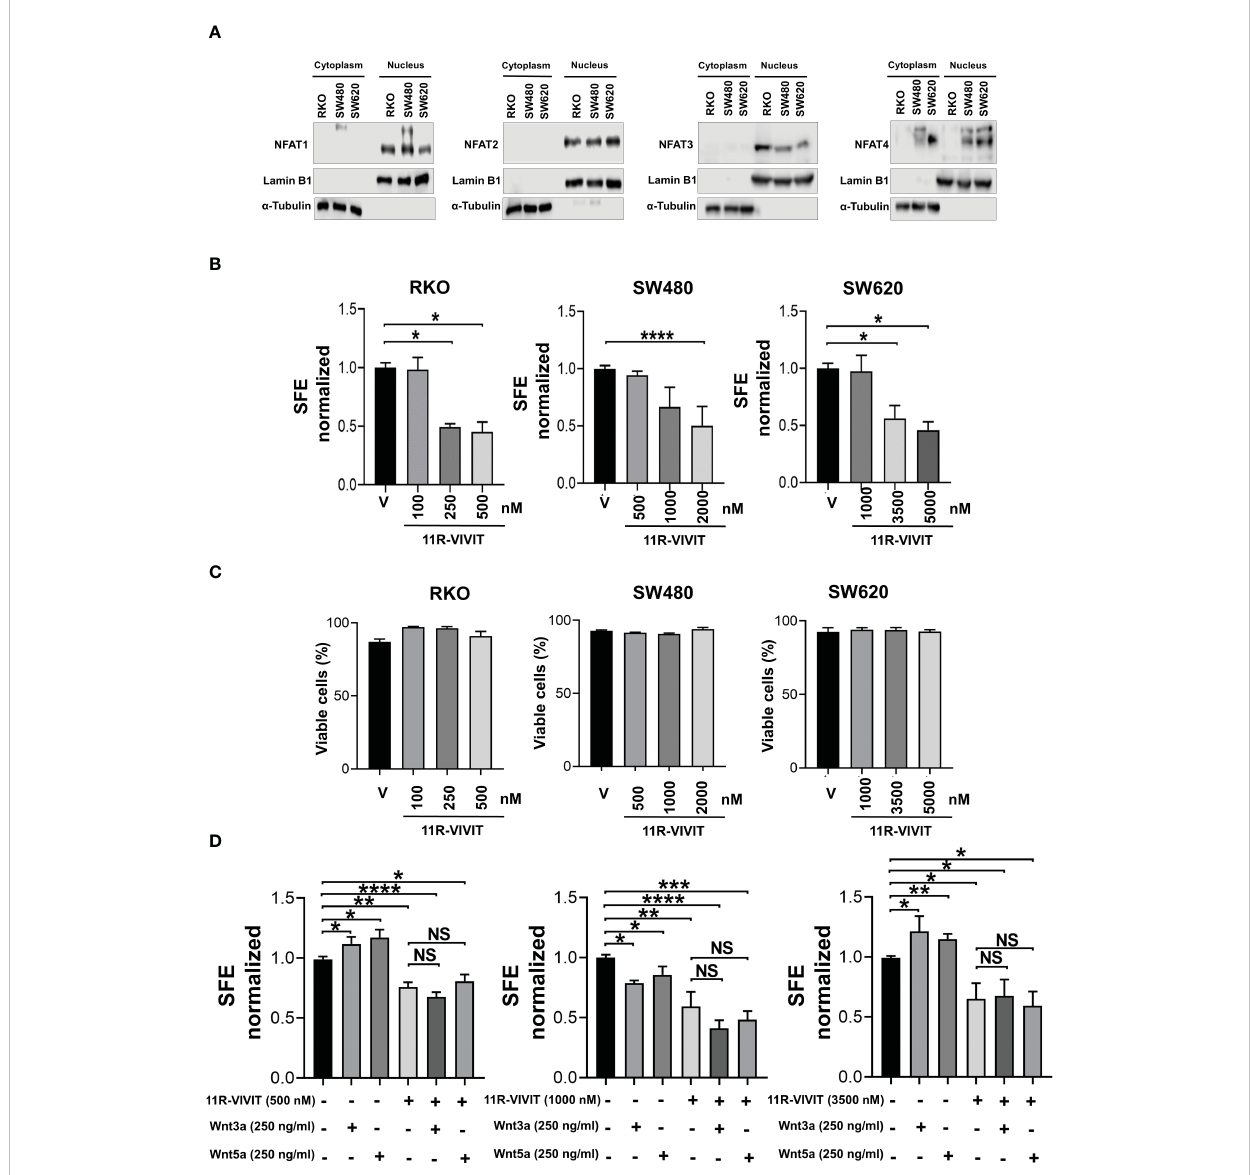
FIGURE 6 NFAT activity is required for spheres formation. (A) Analysis of NFAT1, NFAT2, NFAT3, and NFAT4 expression by Western blot performed in samples obtained from cell fractionation from monolayer cultures. Lamin B1 and a -tubulin were used as a loading control and fractionation purity of nuclear and cytoplasmic fractions, respectively. (B) Quantifying SFE in spheres of RKO, SW480, and SW620 cells treated with the NFAT inhibitor 11R-VIVIT at the indicated concentrations each third day. (C) Quanti fi cation of viable cells of spheres of RKO, SW480, and SW620 under the same conditions described in panel (B) Evaluation was performed by IP staining and detected by fl ow cytometry on the 11 th day of culture. (D) Quantifying SFE in spheres of RKO, SW480, and SW620 cells treated with 11R-VIVIT, Wnt3a, Wnt5a, or their combination. The concentration of each stimulus is indicated in the fi gure. Data are represented as the mean values ± SEM of at least three independent experiments. Statistical analysis was performed using one-way ANOVA followed by Bonferroni´s multiple comparisons. *p<0.05; **p<0.01; ***p<0.001; ****p<0.0001; NS, not signi fi